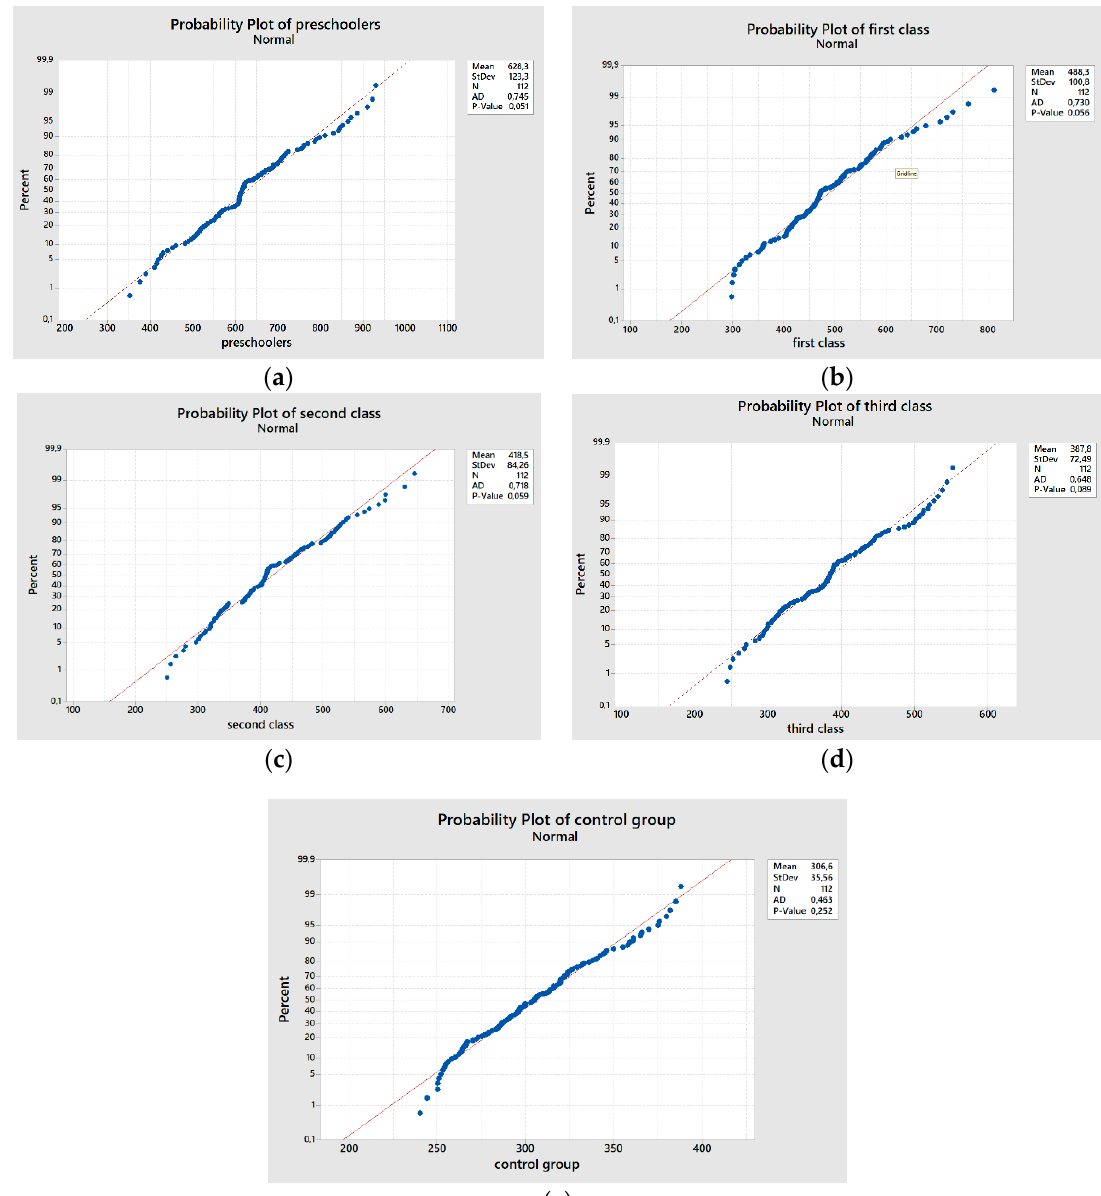
Figure 2. The probability plot of children respondents—preschoolers ( a ), first class ( b ), second class ( c ), third class ( d ) and control group ( e ) of adult drivers. Table 3. F-test for two